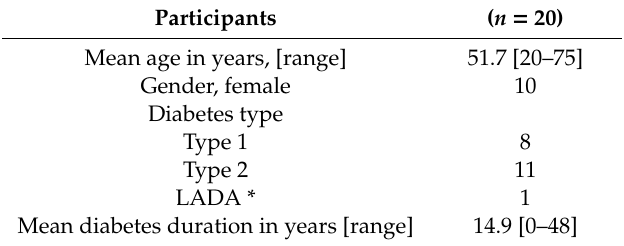
Table 1. Study population